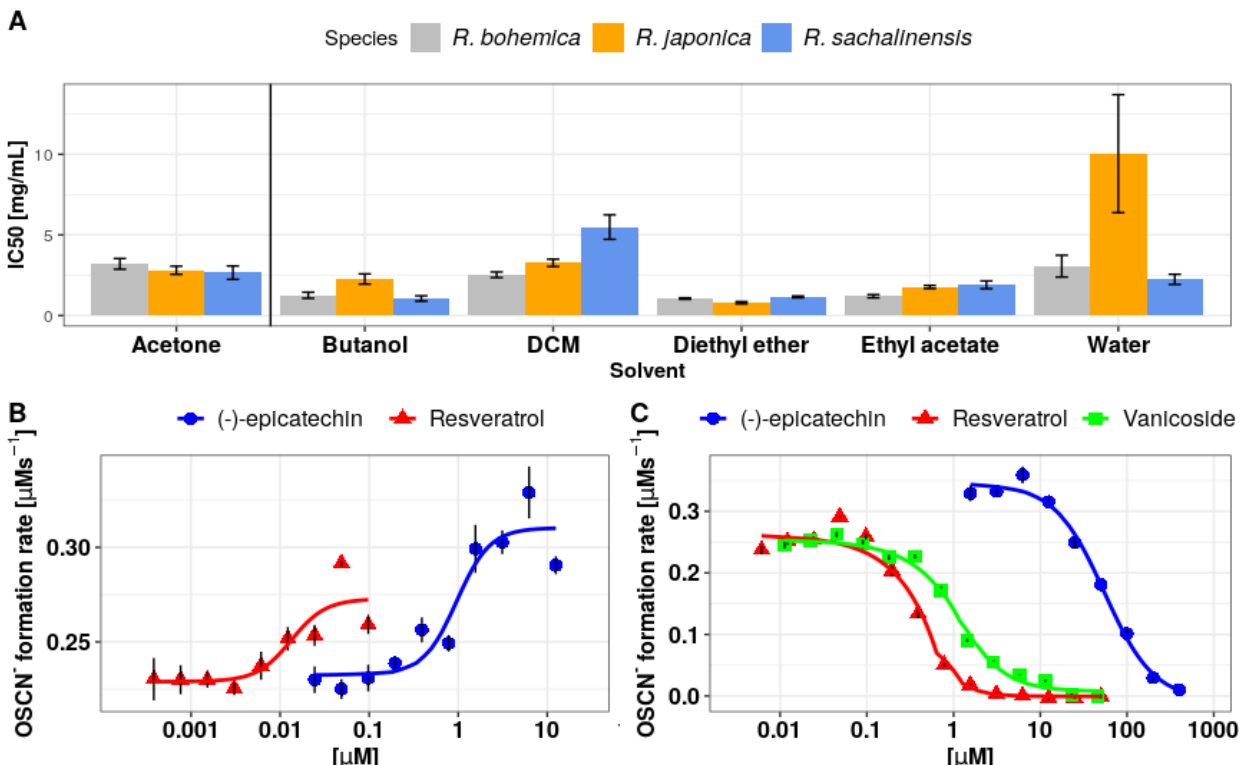
Figure 2. ( A ): IC 50 of acetone extracts from the rhizome of Reynoutria sp. and individual fractions obtained with various solvents. Black lines indicate the standard error of the quadruple marking of each fraction. ( B ): Dose–response curves (the Hill model) showing the activating effect of (-)-epicatechin and resveratrol in relation to the pseudo(halogenation) activity of LPO. ( C ): Dose–response curves (the Hill model) showing the inhibitory effect of (-)-epicatechin, resveratrol, and vanicoside B on the pseudo(halogenation) activity of LPO.